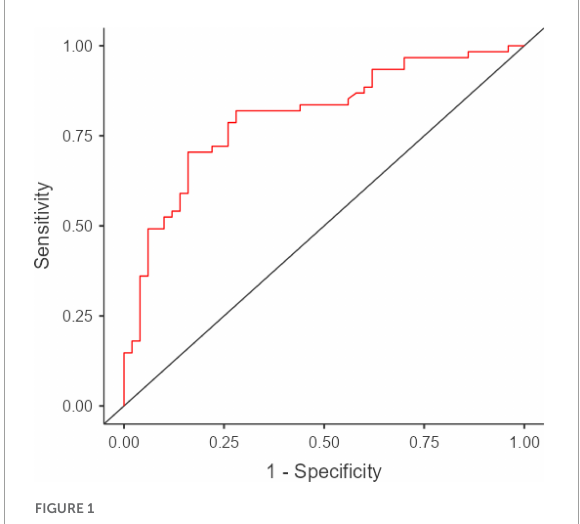
FIGURE1 ROC curve for RMET-adjusted scores in discriminating patients with ALS from HCs. ROC, receiver-operating characteristics; RMET, Reading the Mind in the Eyes Test; ALS, amyotrophic lateral sclerosis; HCs, health controls. AUC = 0.81; SE = 0.04; 95% CI [0.77, 0.92]. Visualization was performed using jamovi 2.3 (https://www.jamovi.org/) by means of the R package ROCR (https://cran.r-project.org/package=ROCR).